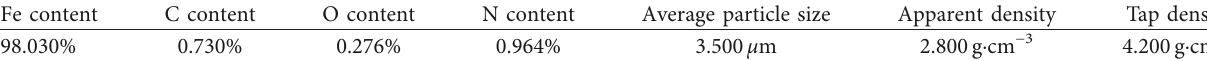
Table 1: The major performance indexes of CIP.